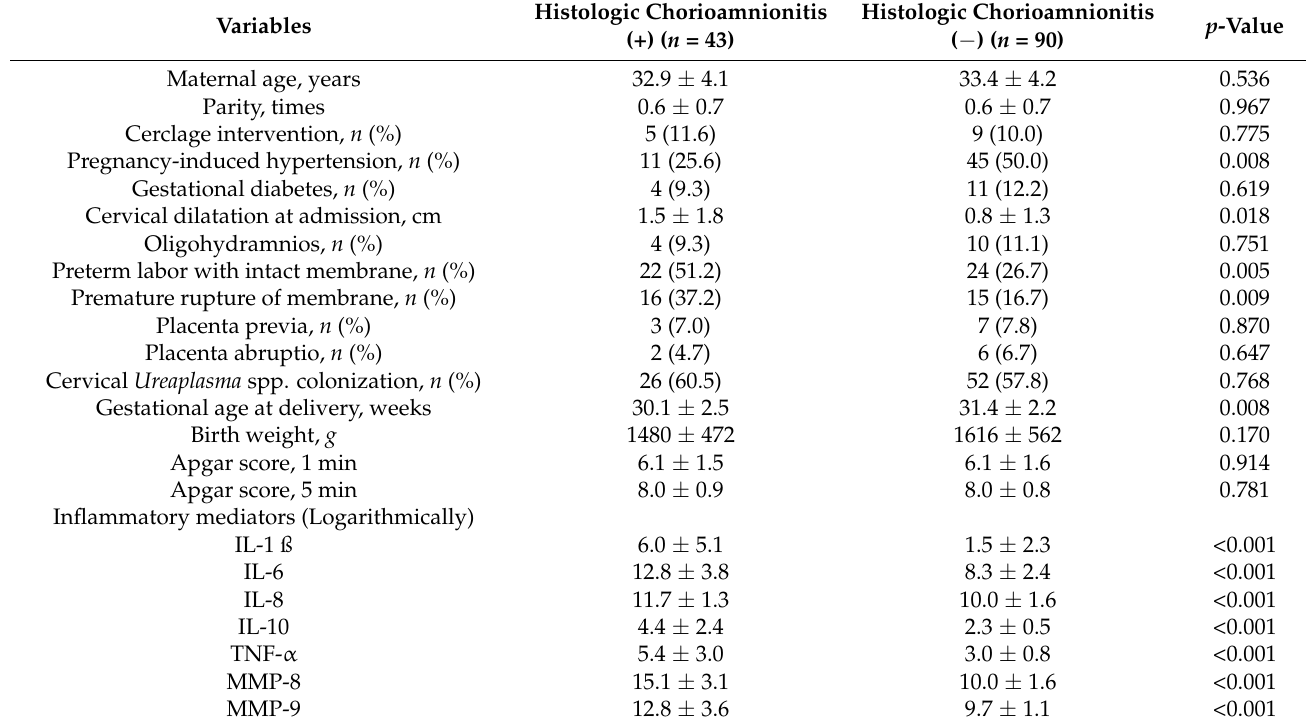
Table 1. A comparison of clinical characteristics and mean values of intraamniotic inflammatory mediators according to the presence or absence of histologic